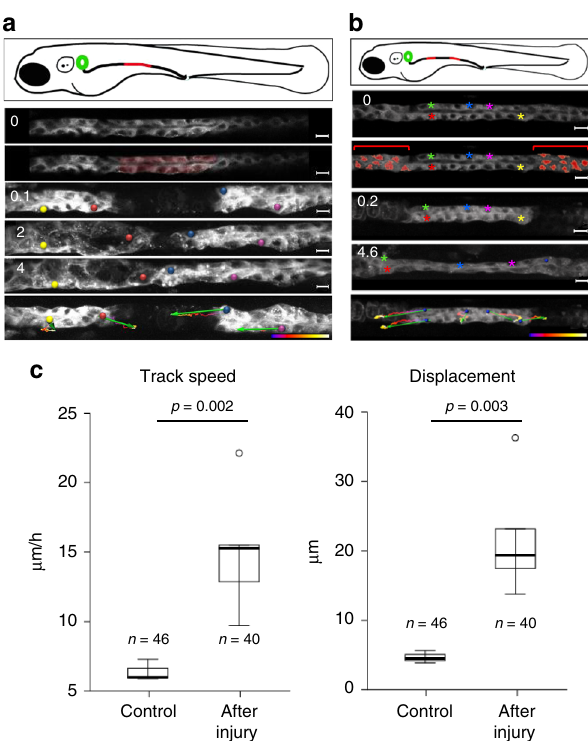
Fig. 2 Pronephric duct injuries are repaired by migration. a Frames from Supplementary Movie 1, showing recovery after ablation of a pronephric duct fragment (ablated cells are marked in red). The free ends of the duct move towards each other, whereby the leading cells extend protrusions and exhibit active cell migration. The bottom panel depicts tracking of individual cells over time. Tracking lines are color coded, ranging from blue to white (0 – 9 h); the green arrows summarize migration direction and cell displacement (scale bars, 10 µ m). b Frames from Supplementary Movie 2. The panel depicts a two-sided cell ablation (red-labeled cells), isolating a patch of pronephric cells. The free ends of the isolated duct migrated in opposite direction, stretching the isolated segment. Whereas the cells in the terminal regions exhibited prominent net displacement, the cells in the middle segment remained almost stationary. Tracking lines are color coded, ranging from blue to white (0 – 9 h) (scale bars, 10 µ m). c To compare repair response and collective cell migration, 2-day-old Tg(-8.0cldnb:LY-EGFP), TgBAC(cxcr4b:h2b-RFP) transgenic zebra fi sh embryos were mounted on the side to image pronephric ducts by confocal microscopy. The pronephros was injured with a two-photon laser at 36 h, and track speed (left panel) ( p = 0.0023, t -test) and track displacement length (right panel) ( p = 0.0034, t -test) was measured over 2 h. After injury, tubular epithelial cells adjacent to the injury almost tripled their speed. The cell number ( n ) was